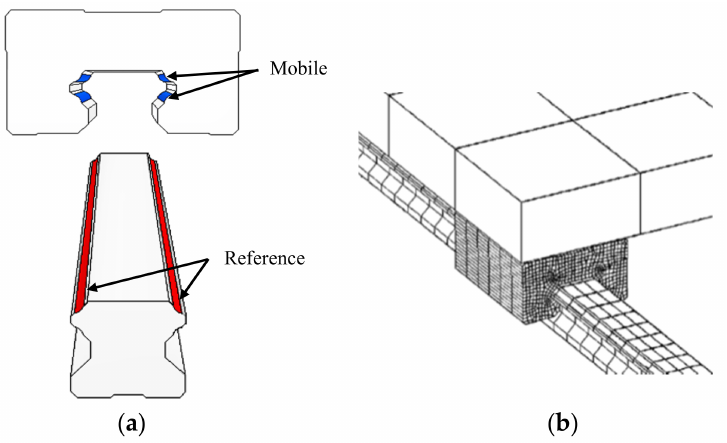
Figure 13. Finite element model for LM Guide: ( a ) contact surfaces of a bushing joint, and ( b ) finite element